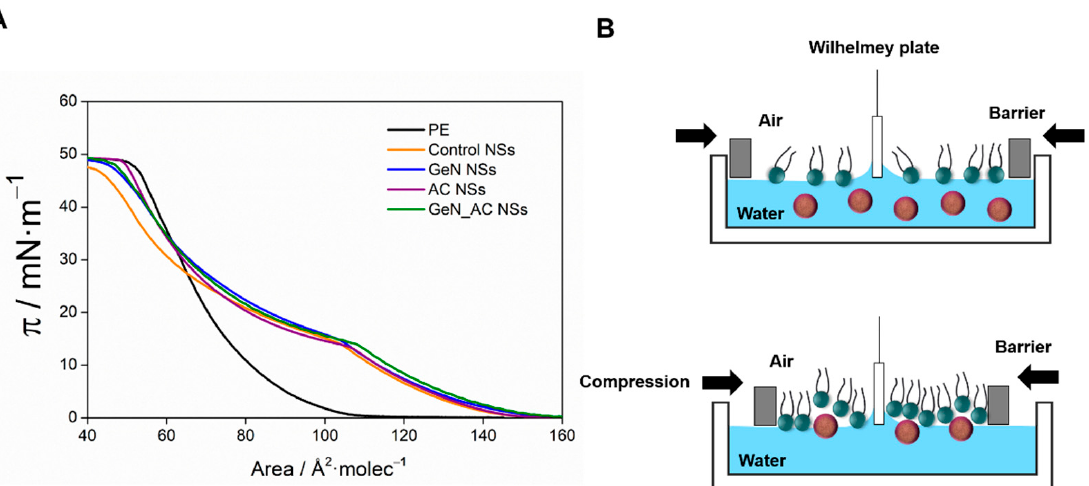
Figure 3. ( A ) Surface pressure-area isotherms of a PE monolayer (the area per molecule in X axis refers to E. coli PE) in water with control, AC, GeN and GeN_AC NSs; ( B ) Schematic representation of the NSs interaction with model bacterial membrane.